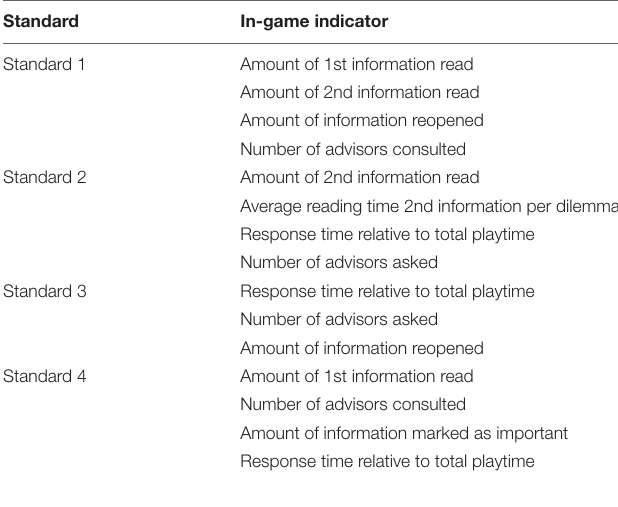
TABLE 4 | Final in-game operationalization of information literacy standards